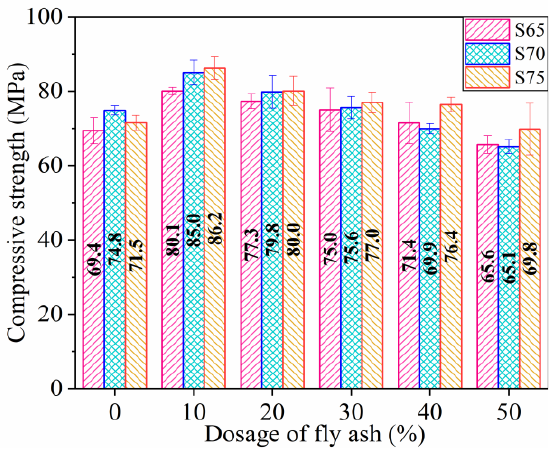
Figure 6. Compressive strength of specimens.